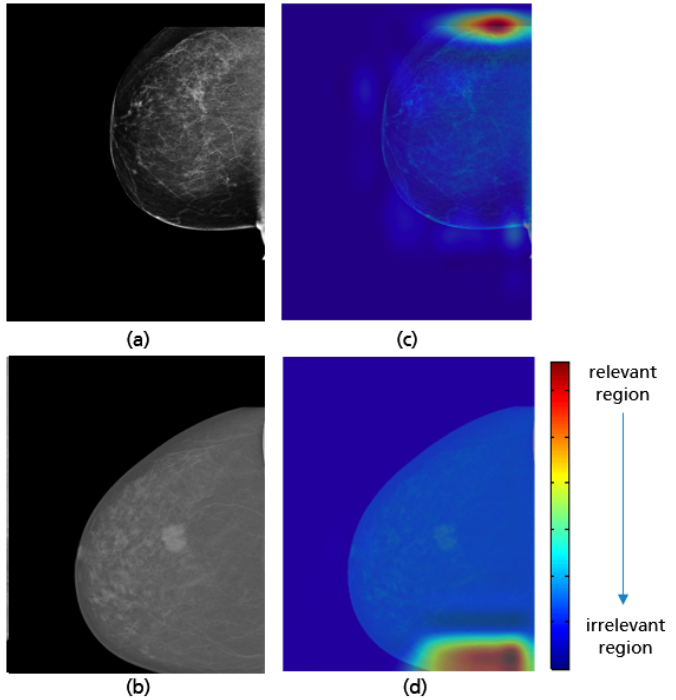
Figure 32. Examples of CC views with missing breast parts in the axillary tail ( a ) and in the lower quadrant ( b ), and their Grad-CAM visualizations showing the identification of the parts not covered during the model predictions ( c , d ).